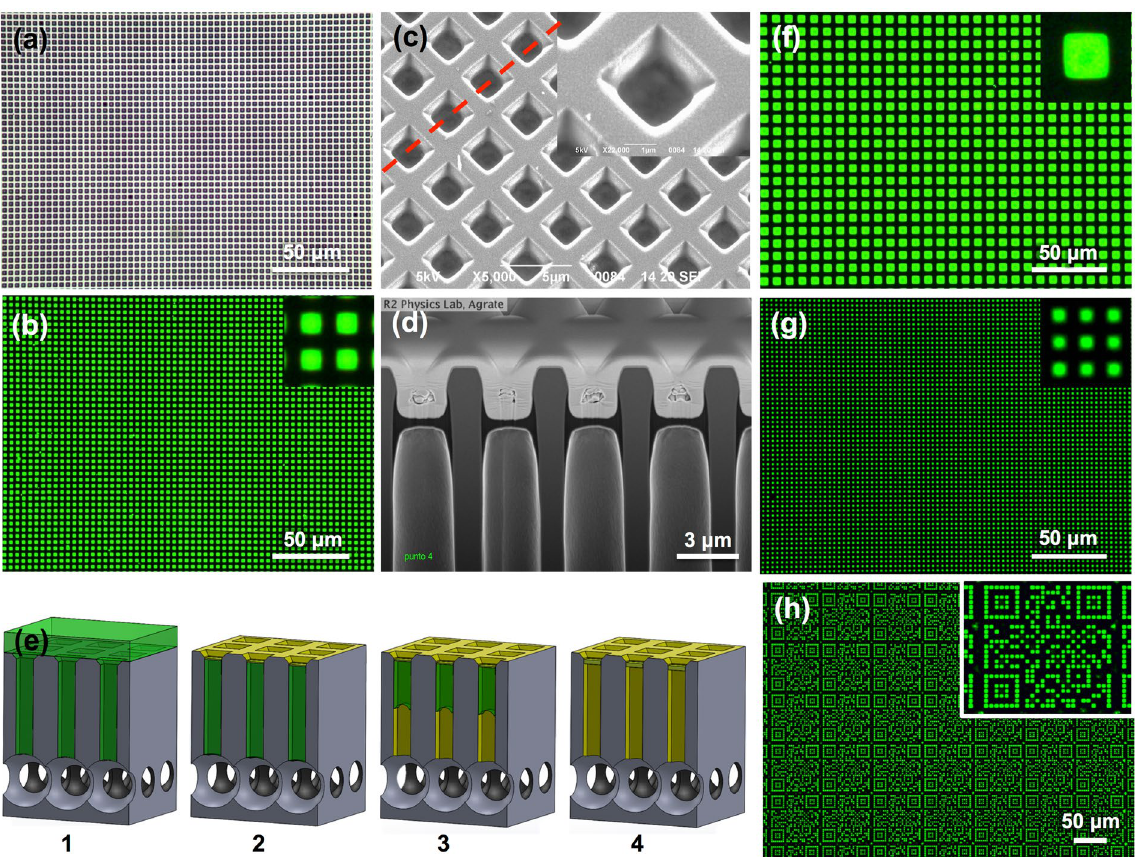
Figure 1. Preparation of High-Density Lattices of Micrometric Suspended F8BT Membranes by Capillarity- Driven Solvent Evaporation. ( a , b , f , g ) Bright-field ( a ) and fluorescence ( b , f , g ) optical images showing a top- view of suspended F8BT membrane lattices prepared drop-casting 10 μ L of 1 wt% polymer solution onto silicon microstructured templates featuring 2D arrays of open-ended micropipes with pitch of 8 ( f ), 4 ( a , b ), and 3 μ m ( g ), with insets highlighting a 10 × 10 μ m 2 area. ( c , d ) SEM micrographs showing a bird’s-eye view ( c ) of the membrane lattice reported in ( a , b ), with inset highlighting a single suspended membrane at higher magnification, and a cross-section view ( d ) obtained by FIB milling process along the red dashed line in ( c ). ( e ) Sketch showing the phases of membrane formation: (e-1) polymer filled open-ended micropipes resulting from capillarity-driven flow developing along the pipes, from inlet (top) to outlet (bottom), after drop-casting deposition, (e-2) formation of a continuous polymer layer covering the silicon microstructure upon solvent evaporation from the solution on top of the microstructure, (e-3) flow menisci moving backward upon solvent evaporation from the solution within the pipes, (e-4) suspended polymer membrane formation at the inlet of open-ended pipes after full solvent evaporation. ( h ) Fluorescence optical image showing typical μ QRs of suspended F8BT membranes obtained drop-casting 5 μ L of 1 wt% polymer solution, and inset reporting a zoom on a single μ